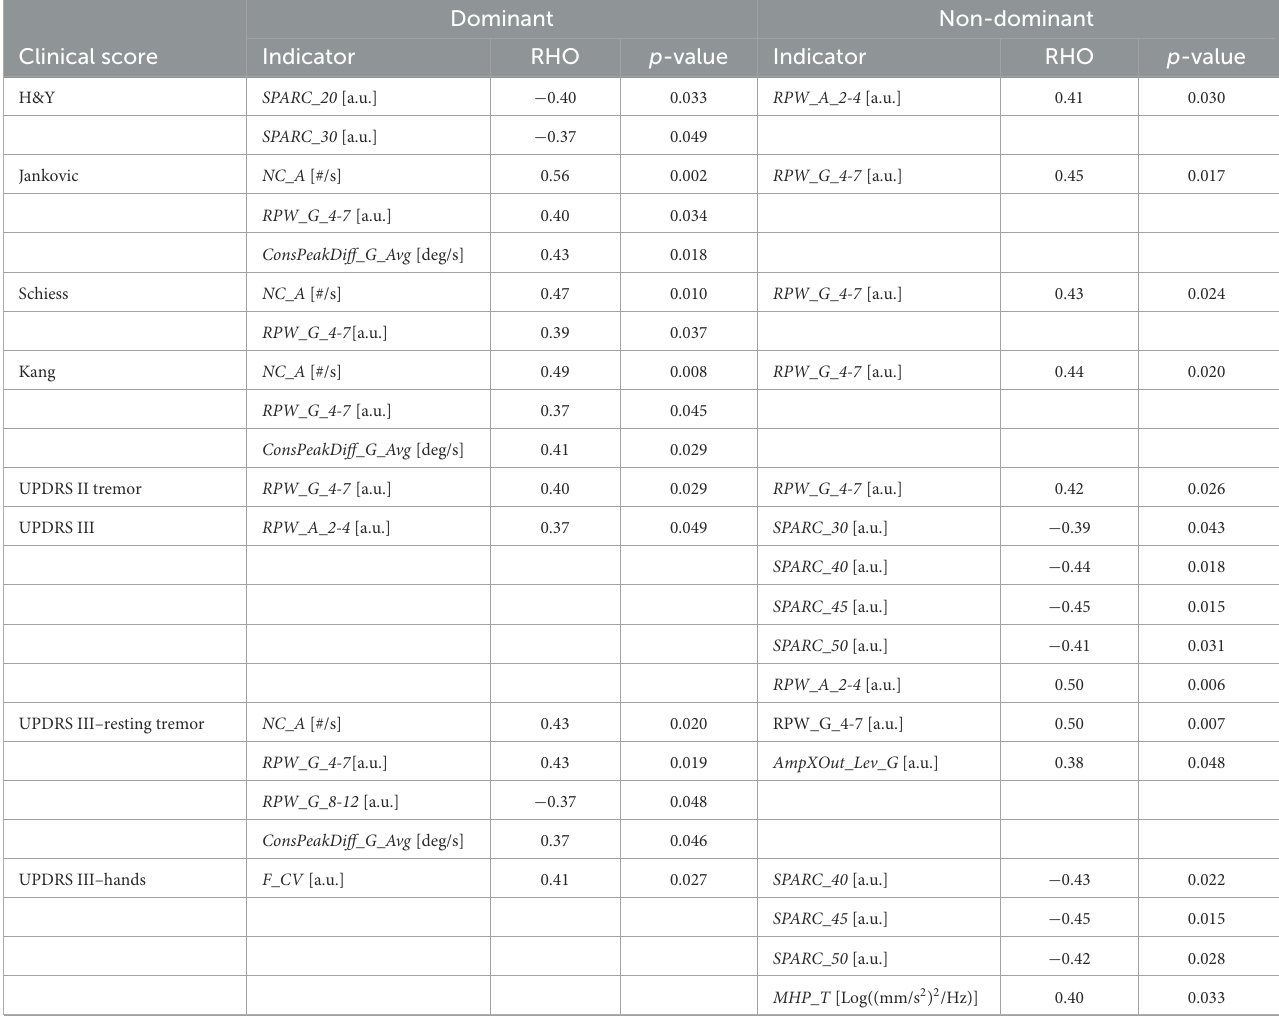
Dominant Non-dominant